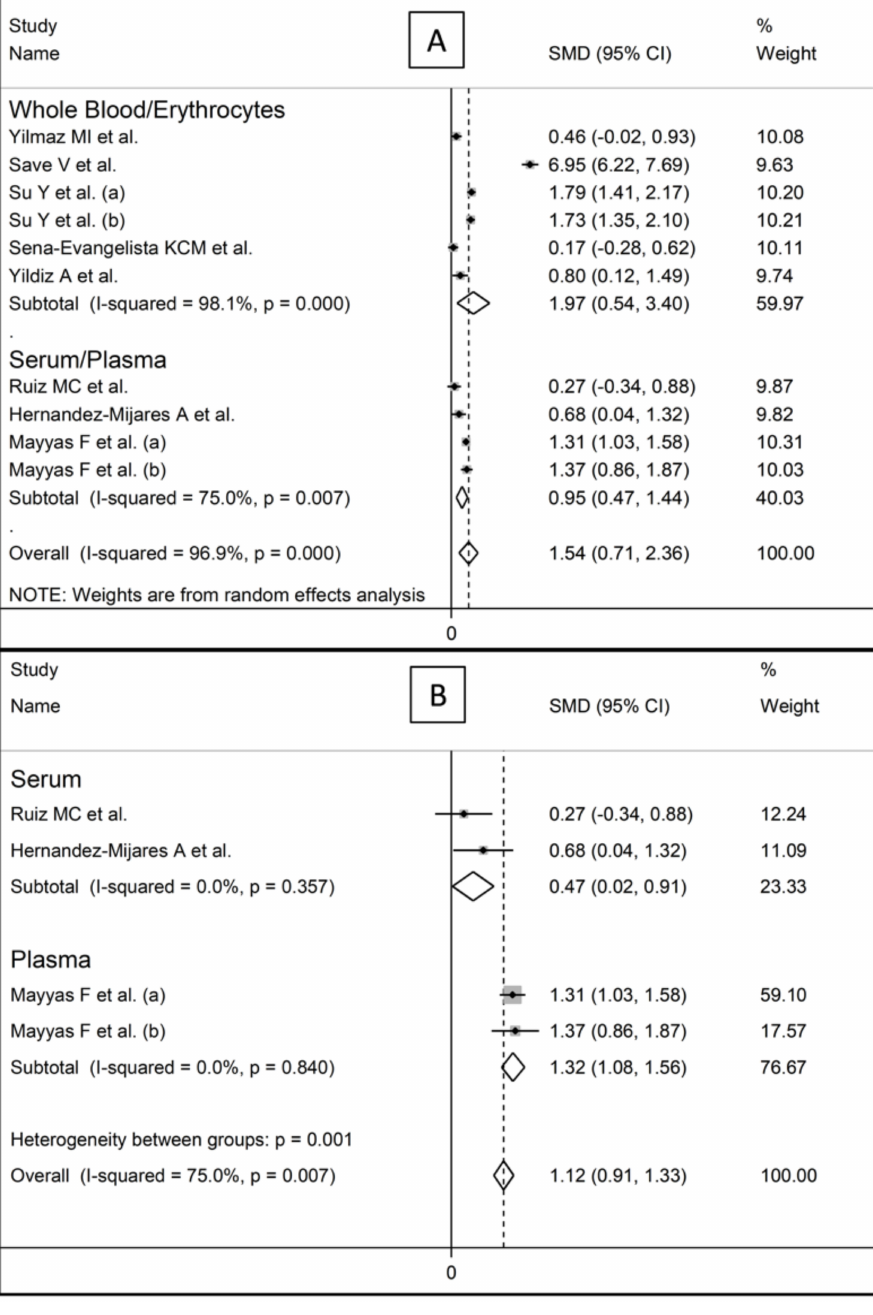
Figure 8. Forest plot of studies investigating SOD concentrations according to the biological